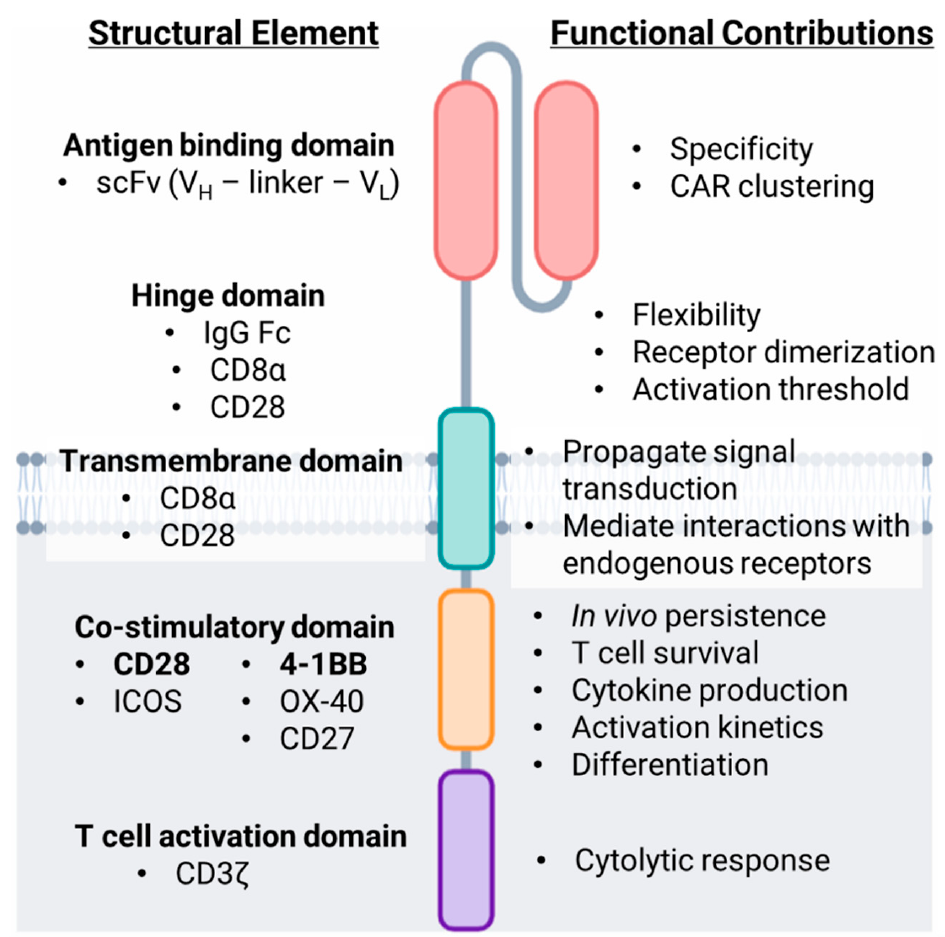
Figure 1. Structure of second-generation Chimeric Antigen Receptor (CAR).